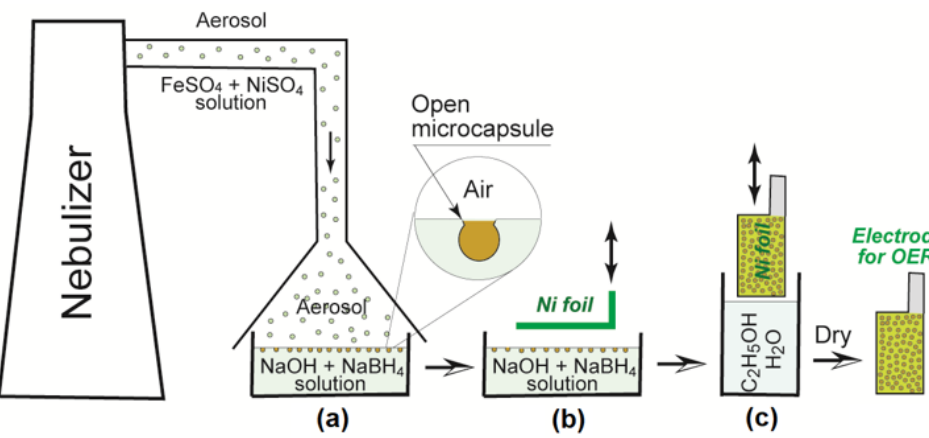
Figure 1. Schematic representation of the operations sequence in the preparation of microcapsules with walls of Ni(II) and Fe(III) double hydroxide: ( a )—the stage of surface treatment of a NaOH and NaBH 4 mixture solution with microdroplets of an aerosol from a mixture solution of NiSO 4 and FeSO 4 ; ( b )—transferring stage of a microcapsules array to the nickel foil surface according to the LS method; ( c )—the stage of sample washing with distilled water and ethyl